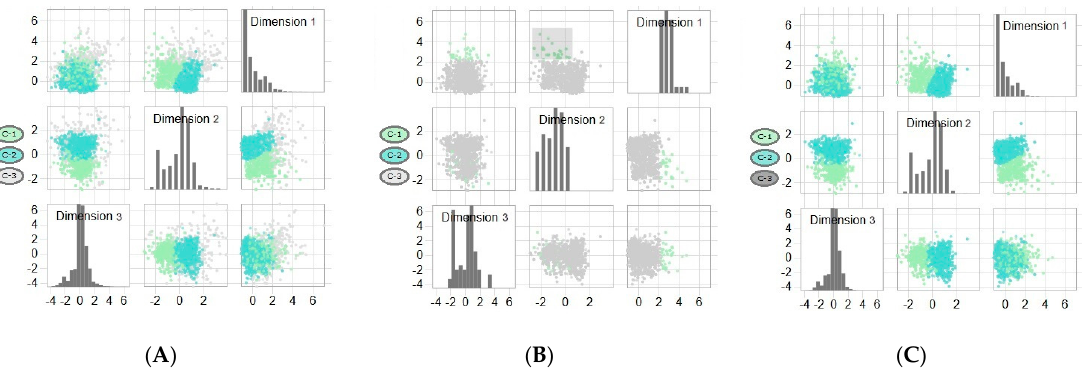
Figure 7. Showing the overview of the projected-observation subview, which displays ( A ) all the observations color-coded based on clusters, ( B ) the brushing interaction, and ( C ) observations in cluster-1 and cluster-2 because cluster-3 is filtered out.